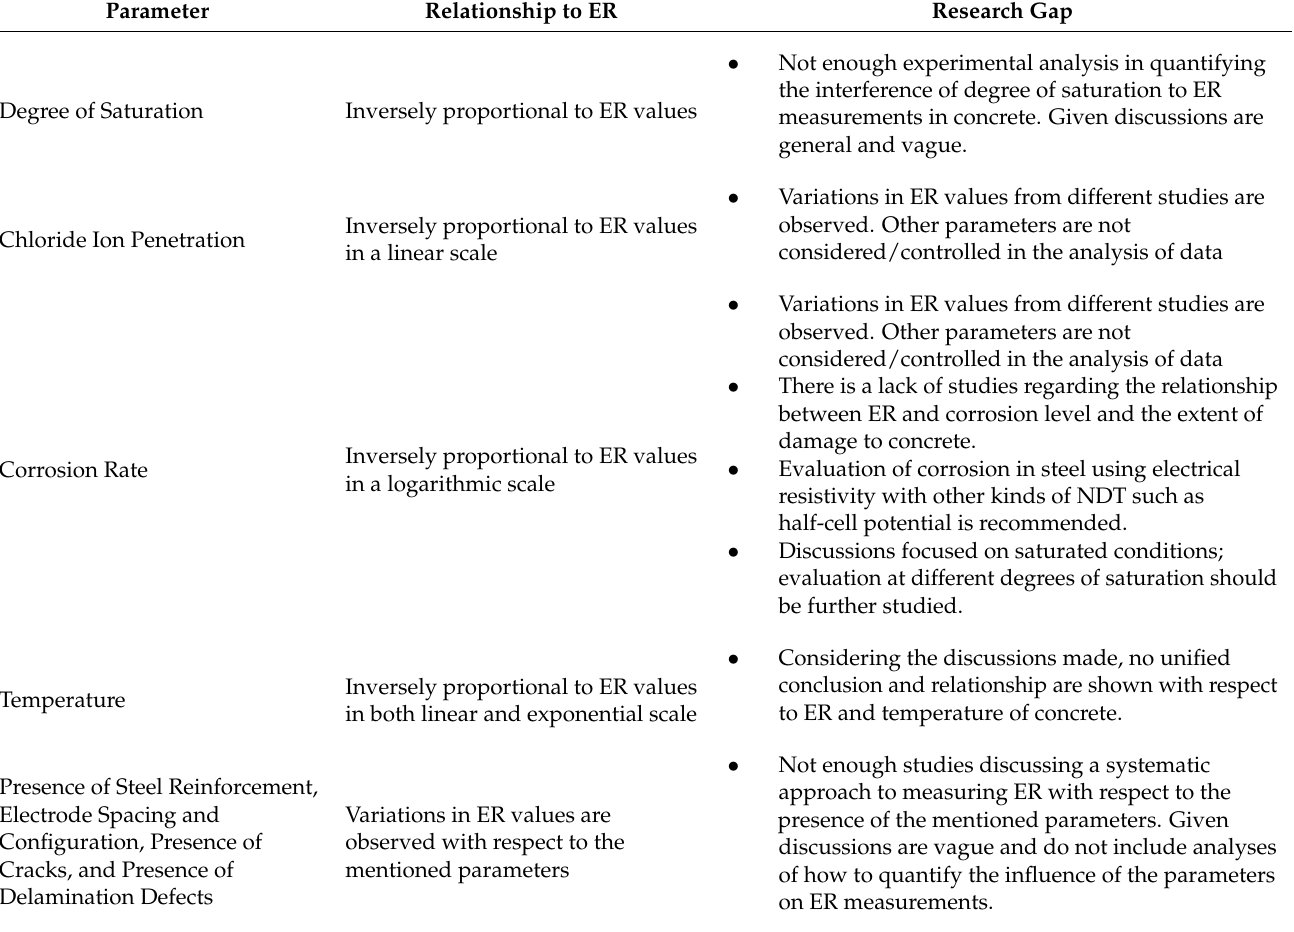
Table 8. Summary of findings and research gap with regards to the relationship of electric resistivity to various environmental factors and